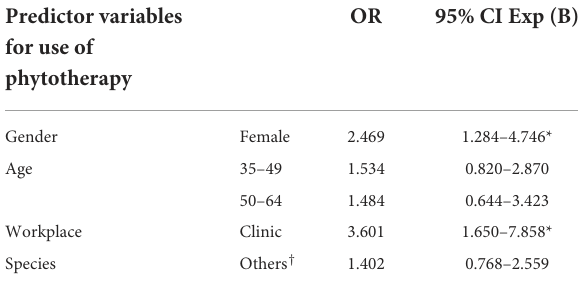
TABLE 8 Multivariate logistic regression analysis showing the association between predictor variables and the use of phytotherapy (reference category: non-use